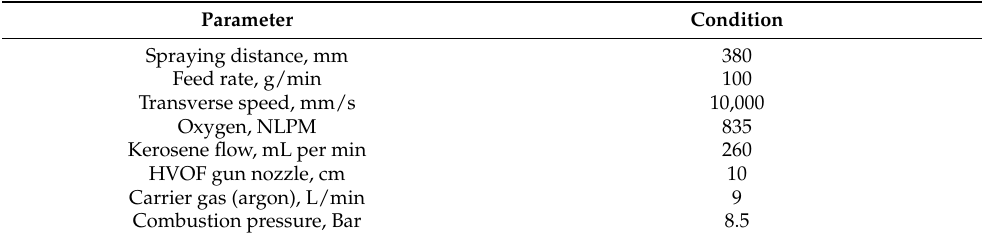
Table 1. Spraying parameters employed in the HVOF